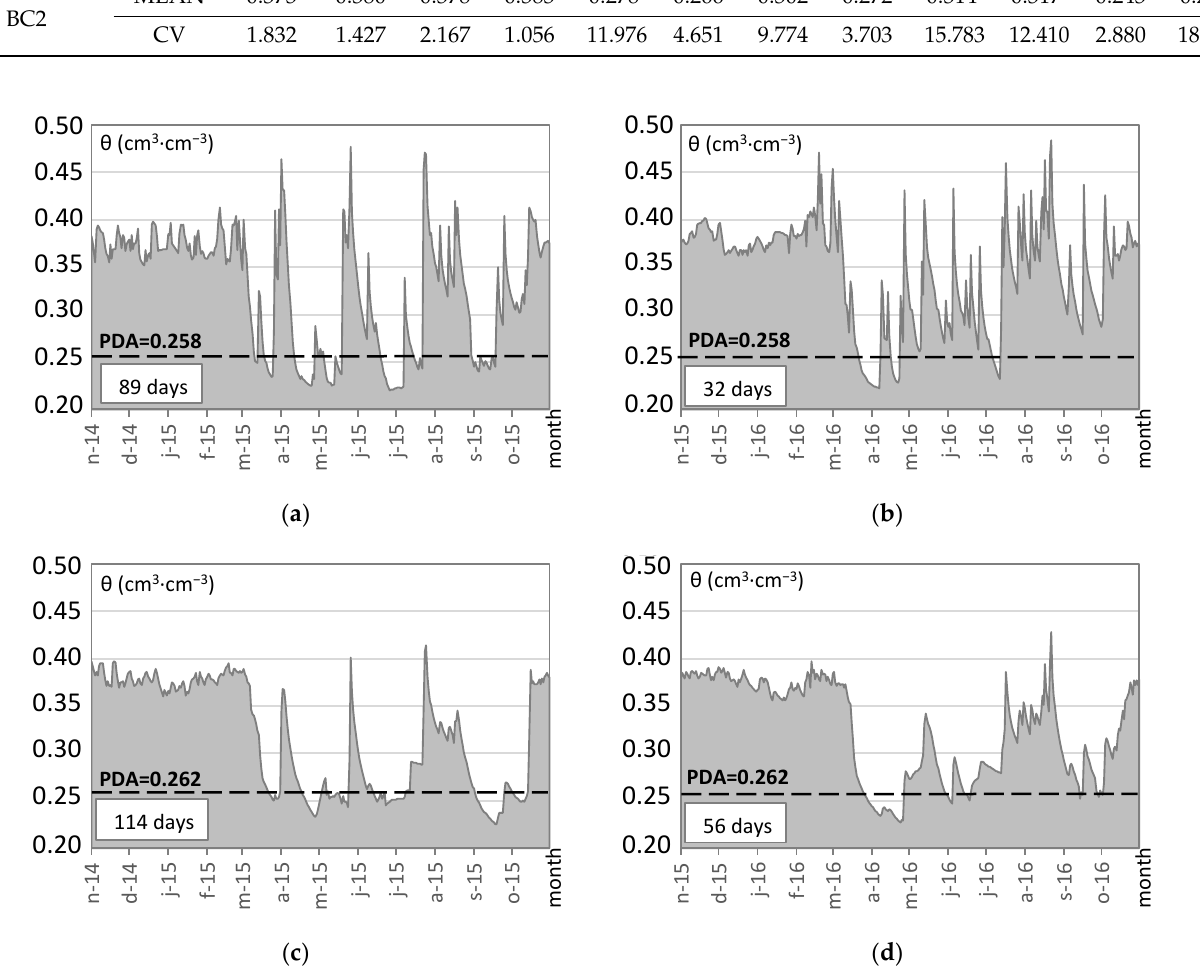
status in the soil profile was indicated. There was an increase in precipitation, as well as a which lasted under the PDA for 20 days in the A horizon. In the B horizon, the soil water content fell below the PDA for 25 days until the second half of September, with a time delay of 3 days (Figure 4a,c). In the B/C1 horizon, a dry episode began 4 days after the B horizon and lasted 40 days. The most unfavourable situation was in the B/C2 horizon, (Figure 5a,c and Table 6).